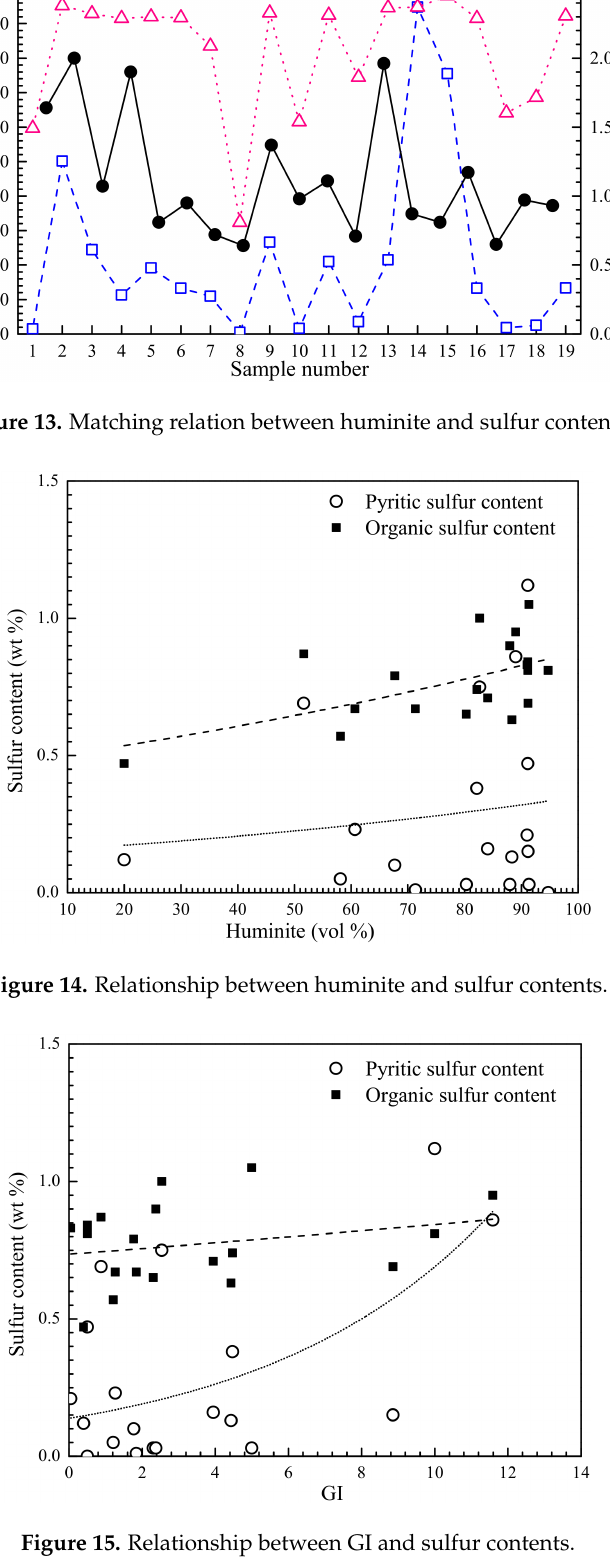
Figure 15. Relationship between GI and sulfur